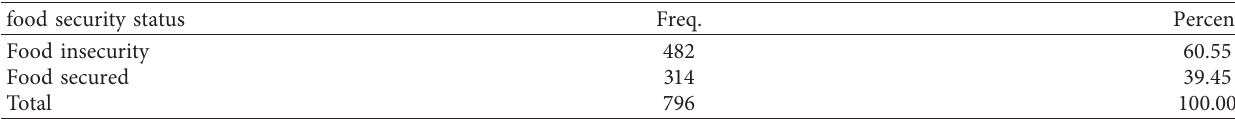
Table 4: Classifications of food security status.